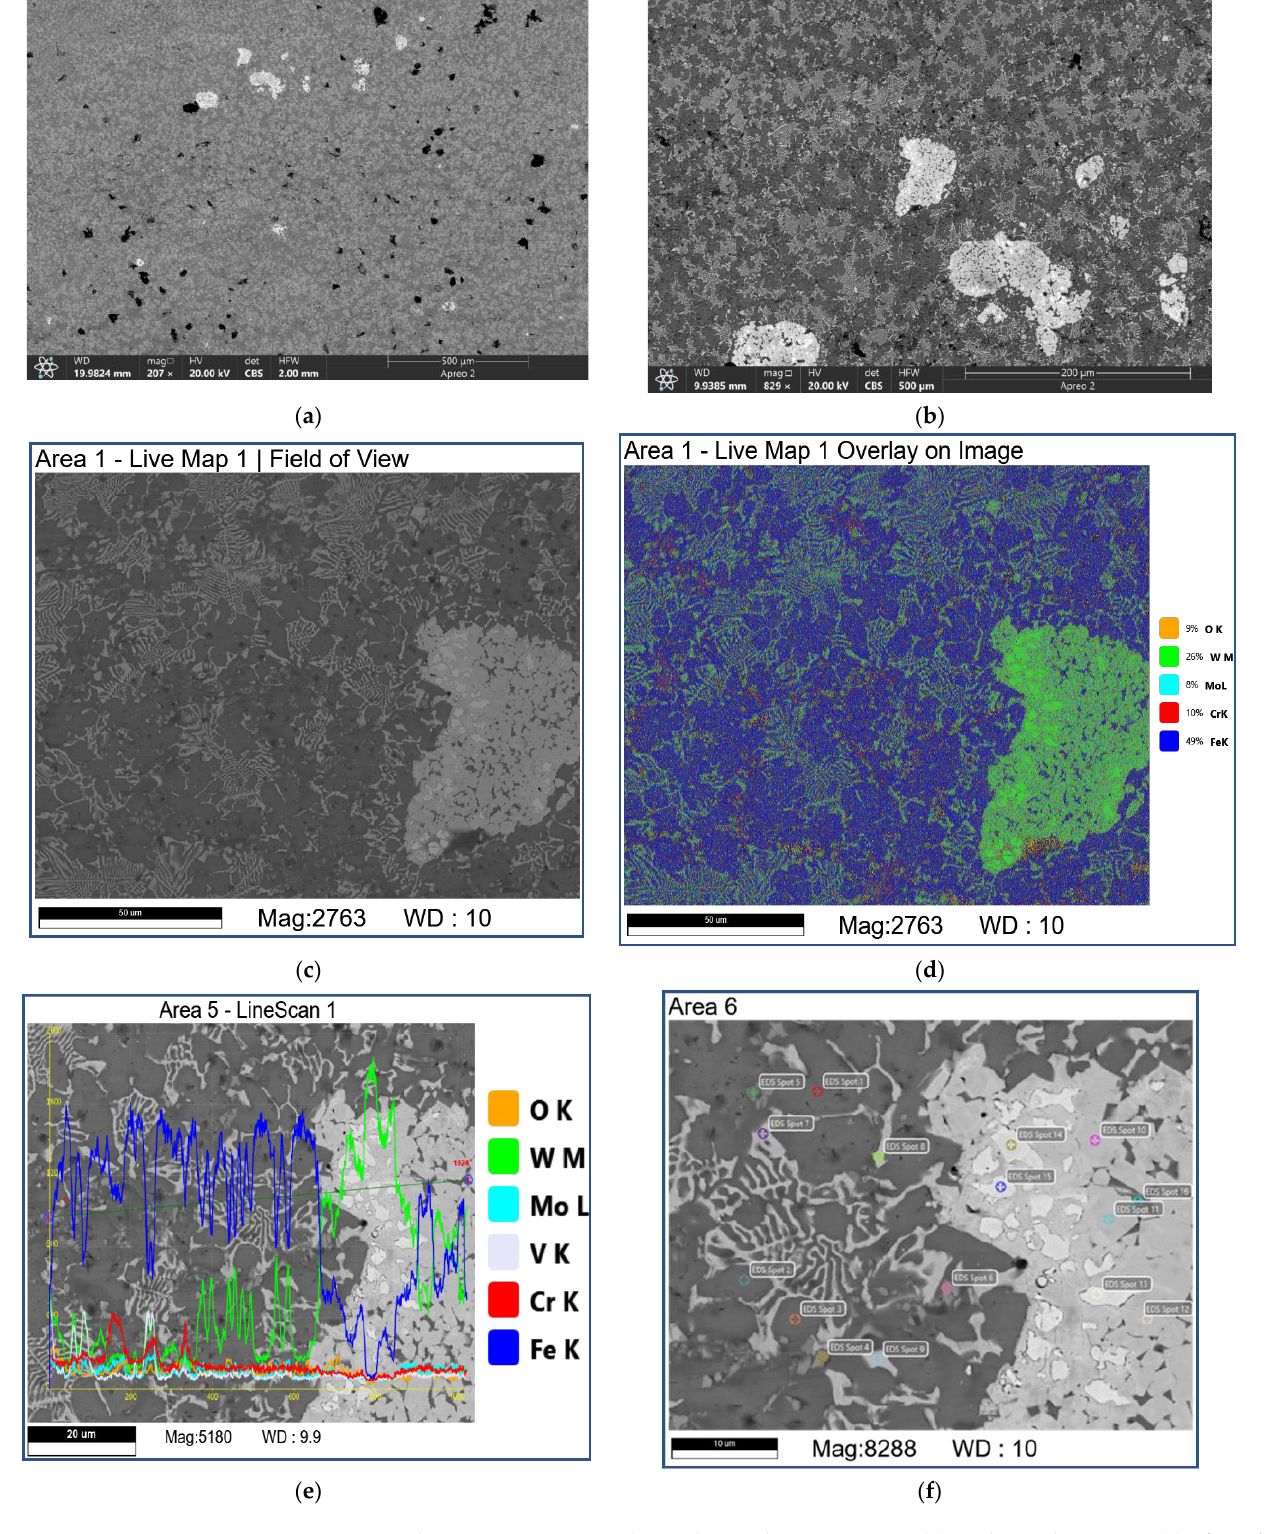
Figure 9. The SEM BSE images ( a – c , e , f ), overlay EDS image ( d ) and EDS line scans ( e ) of M2/W coating worn surface. Data presented for specimens after sliding speed of 0.8 m/s. Numbers on ( f ) indicate probe zones for which EDS elemental concentrations were determined indicated in Table 2.